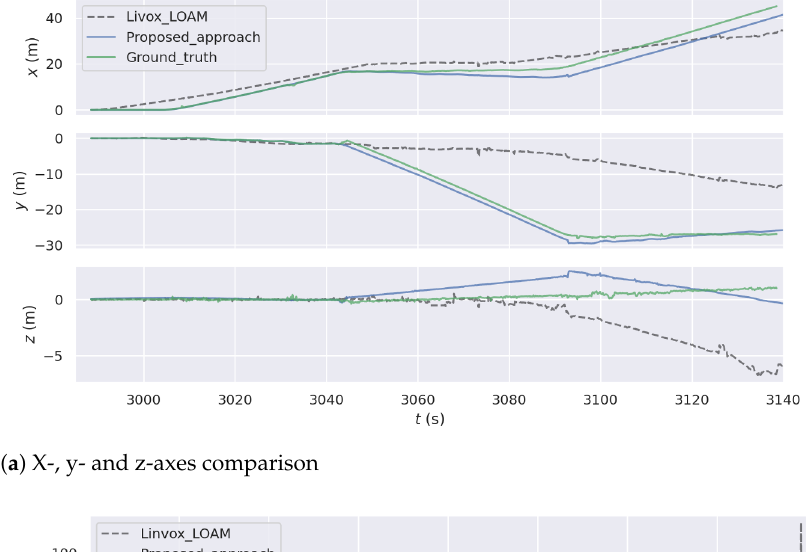
Figure 10. Trajectory Comparison between proposed approach, Livox-LOAM and the ground truth.